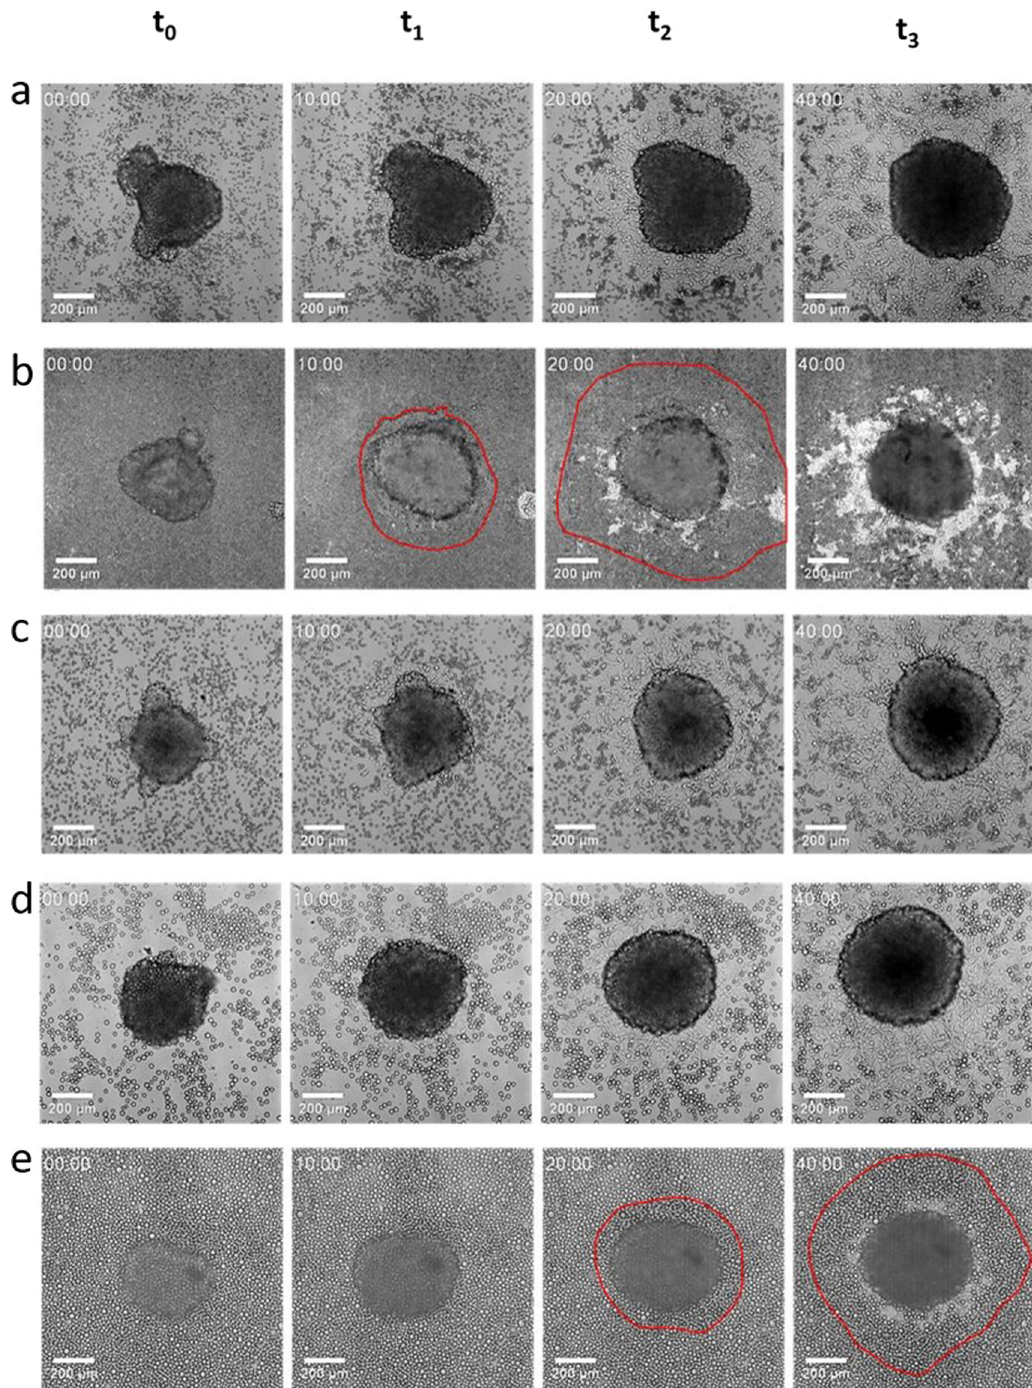
Fig. 2 Cellular aggregates spreading on substrates coated with dense silica microparticles. Bright- fi eld images over time of cell aggregates deposited on substrates decorated with silica microparticles (MPs). a SiO 2 − 5 with surface fraction Φ S = 0.25, b SiO 2 − 5 with Φ S = 0.76. c SiO 2 − 10 with Φ S = 0.13, d SiO 2 − 20 with Φ S = 0.13, e SiO 2 − 20 with Φ S = 0.96. Red contours highlight the limit of the cellular fi lm on the layer of silica MPs when dif fi cult to observe. Cellular aggregates are the spherical structures in the middle. They spread forming a precursor fi lm made of elongated cells around. MPs are the spheres around the precursor fi lm. Time is measured in